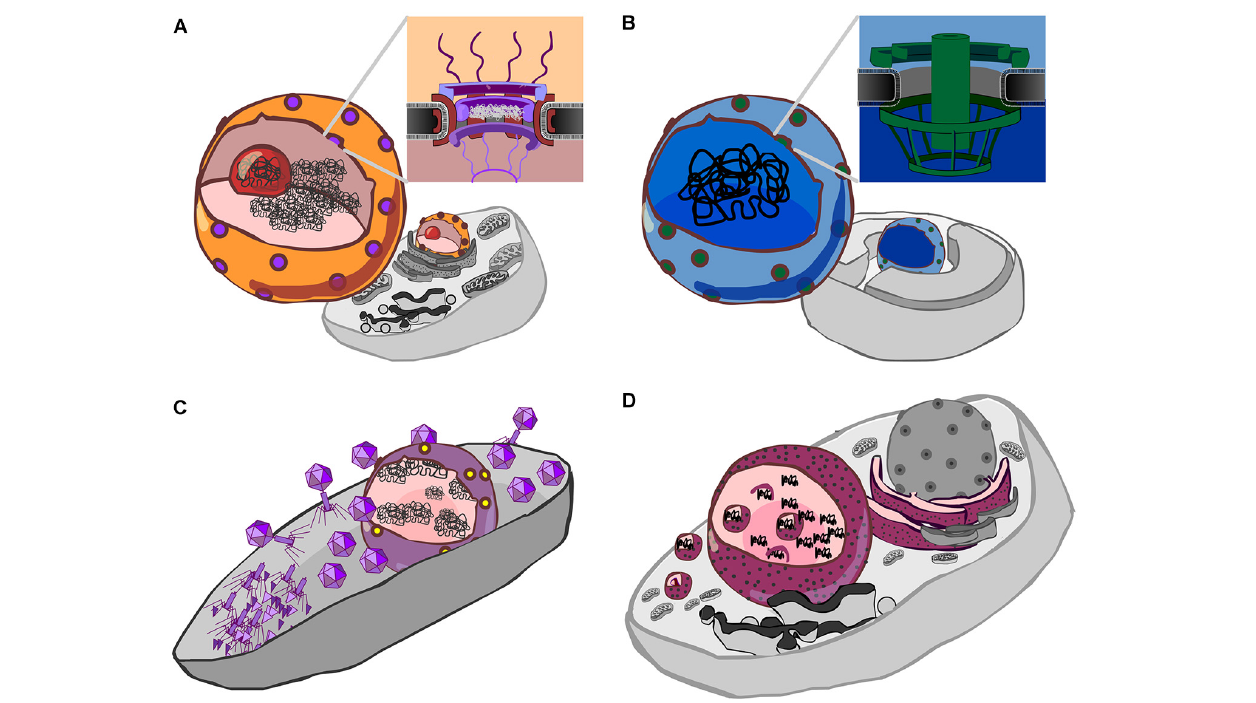
FIGURE 1 | Forms of genetic compartmentation. (A) Cartoon depiction of a eukaryote cell and nucleus (orange) with nuclear pores (purple), nucleolus (red) and DNA (black). Inset: a schematic cross-section of the nuclear pore complex with a central plug, cytoplasmic fibrils above, and basket structure below the plane of the membrane. The inner and outer membranes of the nuclear envelope are continuous. (B) Cartoon depiction of a Gemmata obscuriglobus cell showing internal membranes (Fuerst and Sagulenko, 2011), a proposed nucleus-like structure (blue) which contains DNA, and pores (green). Inset: a schematic of the nuclear pore-like structure reported by Sagulenko et al. (2017). (C) Cartoon detailing the Jumbo phage proteinaceous nucleus-like structure (purple) containing phage DNA (black), after Chaikeeratisak et al. (2017b). Protein synthesis and viral assembly occurs outside this structure, whereas DNA replication and transcription occur within. This suggests the presence of a mechanism for both export of RNA and DNA, depicted here as a single complex by yellow dots. (D) Cartoon detailing co-option of the endoplasmic reticulum by Mimivirus, a Nucleocytpplasmic Large DNA virus (NCLDV). Here, the rough endoplasmic reticulum (maroon with black speckles) is recruited to form an encapsulating virus factory (Mutsafi et al., 2013). A complex series of events then leads to formation of viral capsids which are then encapsulated by protein-coated membranes (Kuznetsov et al., 2013) (depicted by small magenta spheres).